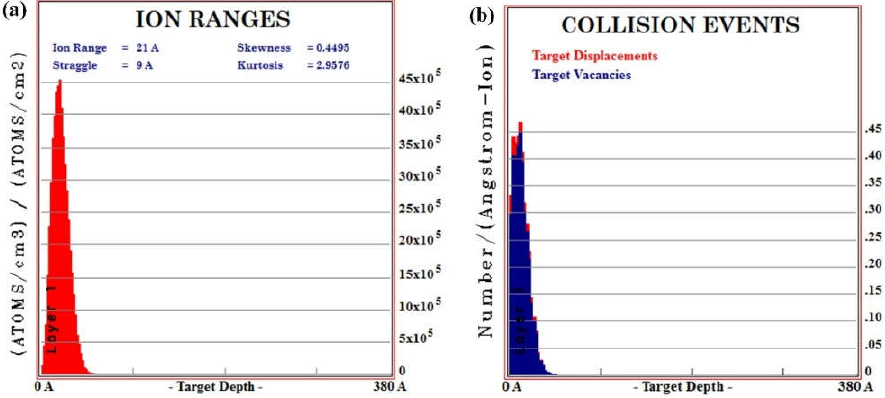
Figure 4. Monte Carlo simulation results of IBS process, ( a ) Ar atoms distribution, ( b ) damage distribution. Based on MD simulation, the Ar atoms distribution and corresponding Gaussian dis- tribution fitting in the z direction are presented in Figure 5. For Al(001), the average depth of bombardment is around 70 Å. As the depth increases, the number of Ar atoms de- creases, which conforms to the actual processing conditions. Al(111) shares the same reg- ularity with Al(001). However, according to the expectation and variance, the distribution of Ar atoms is more concentrated and the depth is shallower. For Al(110), Ar atoms are more evenly distributed relatively. The average depth of bombardment is 146 Å, which is the deepest among the three crystal orientations.